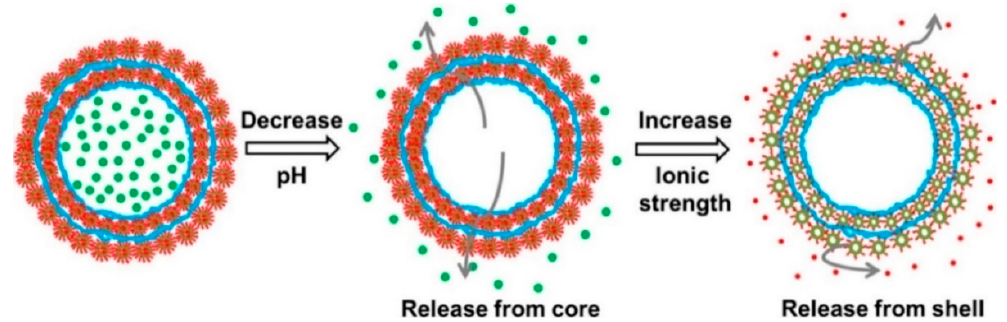
Figure 13. Independent release of anionic FITC-dextran and cationic rhodamine B from PEG- Independent release of anionic FITC-dextran and cationic rhodamine B from qPDMAEMA 4 micelle/tannic acid-derived microcapsule cores and shells. Reprinted with permission PEG-qPDMAEMA 4 micelle / tannic acid-derived microcapsule cores and shells. Reprinted with from reference [64] . Copyright 2014 American Chemical Society. permission from reference [64]. Copyright 2014 American Chemical